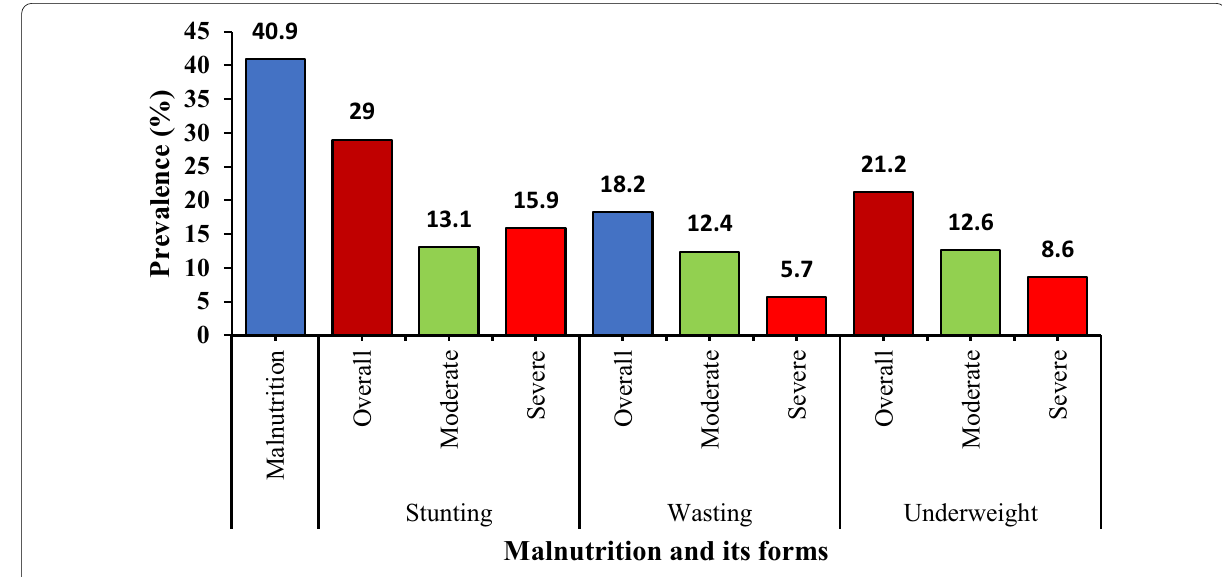
Fig. 1 The prevalence of malnutrition and its severity in the study population